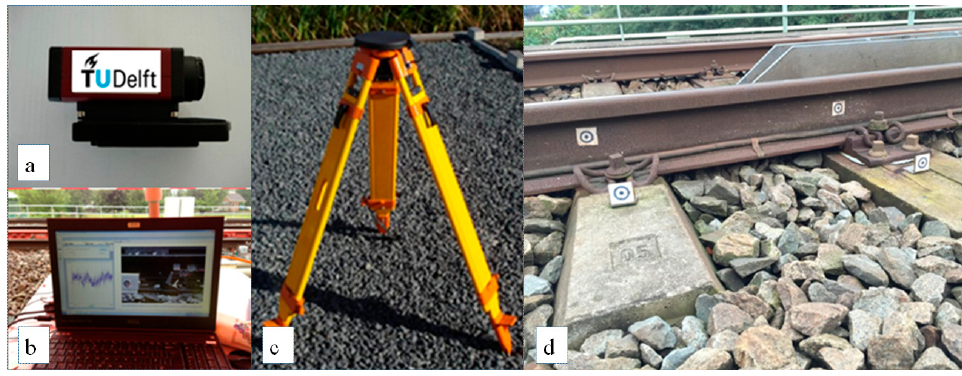
Figure 4. A DIC-based device: ( a ) a high-speed camera; ( b ) processing system; ( c ) a tripod; ( d ) targets.